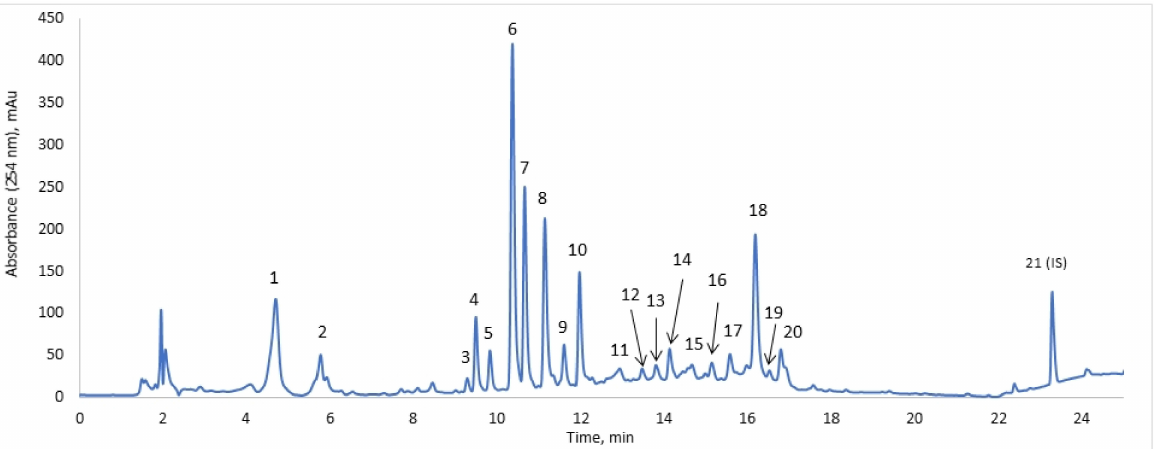
Figure 2. Chromatogram of DE, with selected peaks for quantification. The results of identification are presented in Table 1. Peak 21—internal standard, bicalutamide, 40.0